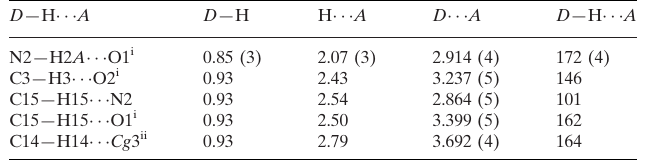
Data collection Stoe IPDS 2 diffractometer Absorption correction: integration ( X-RED32 ; Stoe & Cie, 2002) T min = 0.505, T max = 0.616